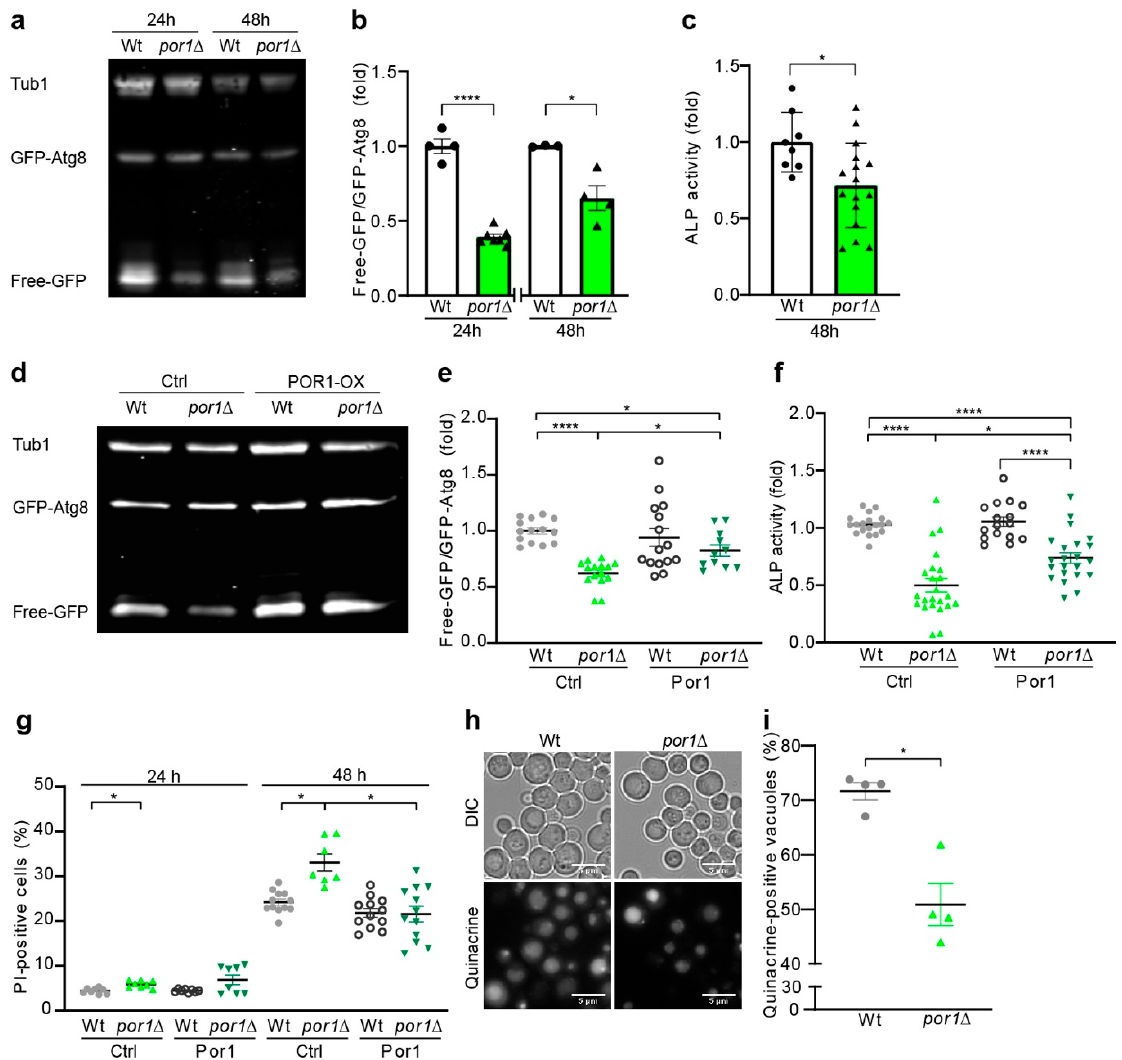
Figure 1. Deletion of POR1 impaired autophagy. ( a – c ) The autophagic flux was reduced in por1 ∆ at 24 h and 48 h (growth on YPD medium). GFP liberation using GFP–Atg8-expressing cells was detected by immunoblotting ( a ) and densitometric quantification of free-GFP/GFP–Atg8 ratios ( b ). The immunoblots were probed with GFP- and tubulin-specific antibodies, and the signals were normalised to wildtype (Wt) ( n ≥ 3). Alkaline phosphatase activity was assessed using the Pho8 ∆ 60 assay indicative for autophagic flux at 48 h normalised to wildtype ( n ≥ 8) ( c ). ( d , e , f ) Reduced autophagic flux in por1 Δ can be restored by POR1 expression after 24 h of induction on SCD/SCG (1:1). A representative immunoblot of wildtype and por1 Δ cells with and without expression of POR1 is shown in ( d ), and densitometric quantification of free-GFP/GFP–Atg8 ratios is depicted in ( e ). Immunoblots were probed with GFP- and tubulin-specific antibodies and signals were normalised to wildtype levels ( n ≥ 11). Alkaline phosphatase activity was assessed at 24 h using the Pho8 ∆ 60 assay ( n ≥ 18) ( f ). ( g ) Chromosomal POR1 deletion triggers cell death, which can be rescued by POR1 expression from a plasmid and induction on SCD/SCG (1:1). Cell death was assessed by PI staining at indicated time points and quantified using flow cytometry ( n ≥ 7). ( h , i ) Quinacrine staining at 24 h on SCD/SCG (1:1) media monitors reduced vacuole acidification in por1 Δ cells. Representative micrographs are shown in ( h ), and cells with acidic vacuoles are quantified in ( i ) ( n = 4). Statistical analysis was performed with Graphpad Prism. p values indicate statistical significance of the Student t -test in ( b , c , i ) and Welch’s ANOVA in ( e , f , g ) with * p < 0.05 and **** p < 0.0001.